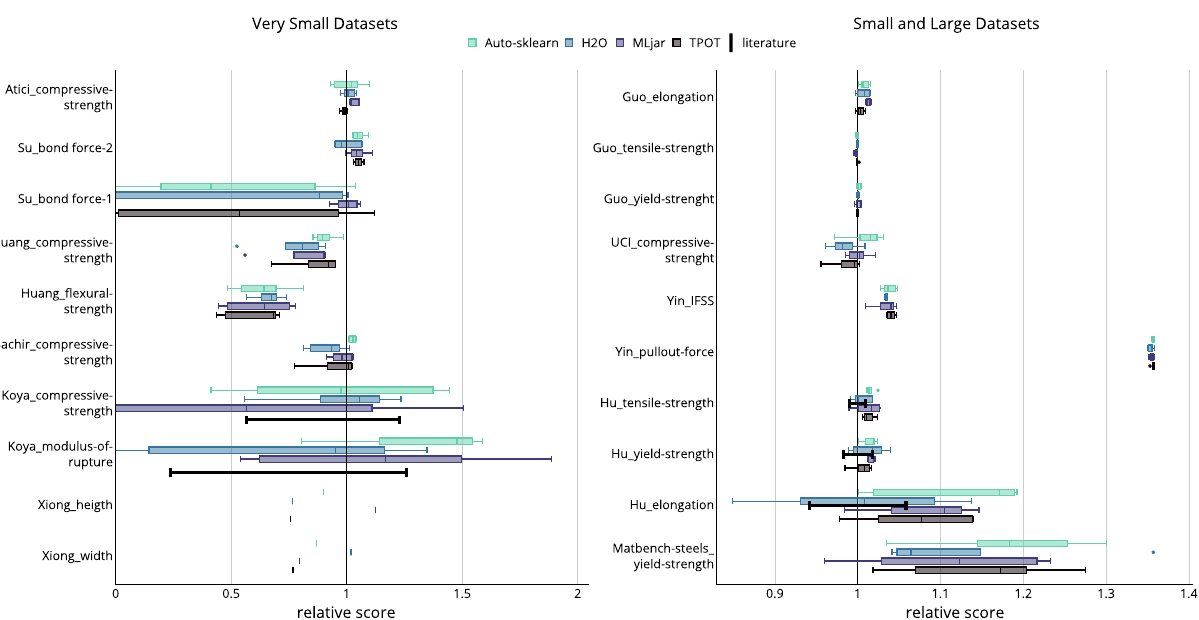
Figure 5. The relative score from the outer splits per task. Relative score means MAE rel for Matbench- 2 steels, MAPE rel for Xiong and R rel otherwise. For Hu and Koya the literature provides a performance range, represented by a black “error